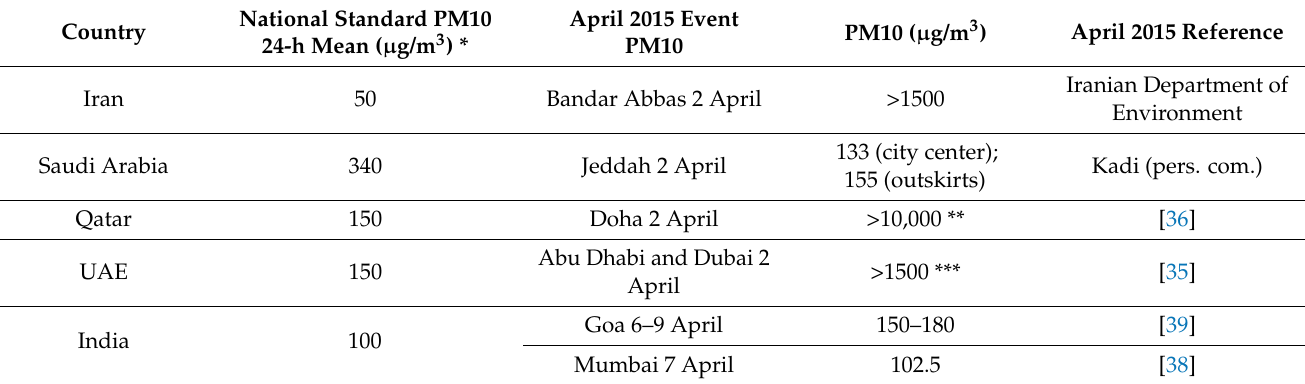
Table 2. Particulate matter (PM) daily mean standards exceeded during the April 2015 dust storm